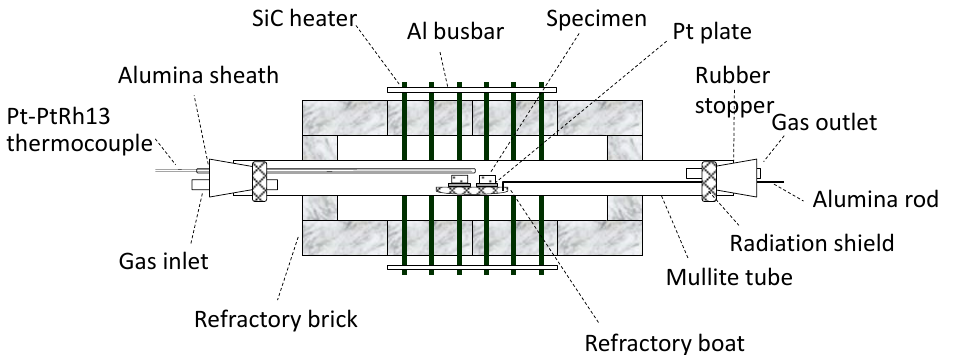
Figure 2. Schematic illustration of the experimental setup.